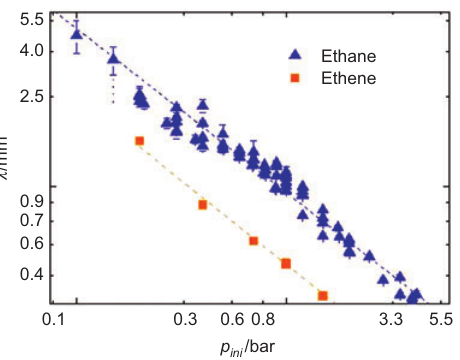
Figure 9 Correlation between initial pressure and mean detonation cell width for stoichiometric mixtures (equivalence ratio = 1) at ambient temperatures.